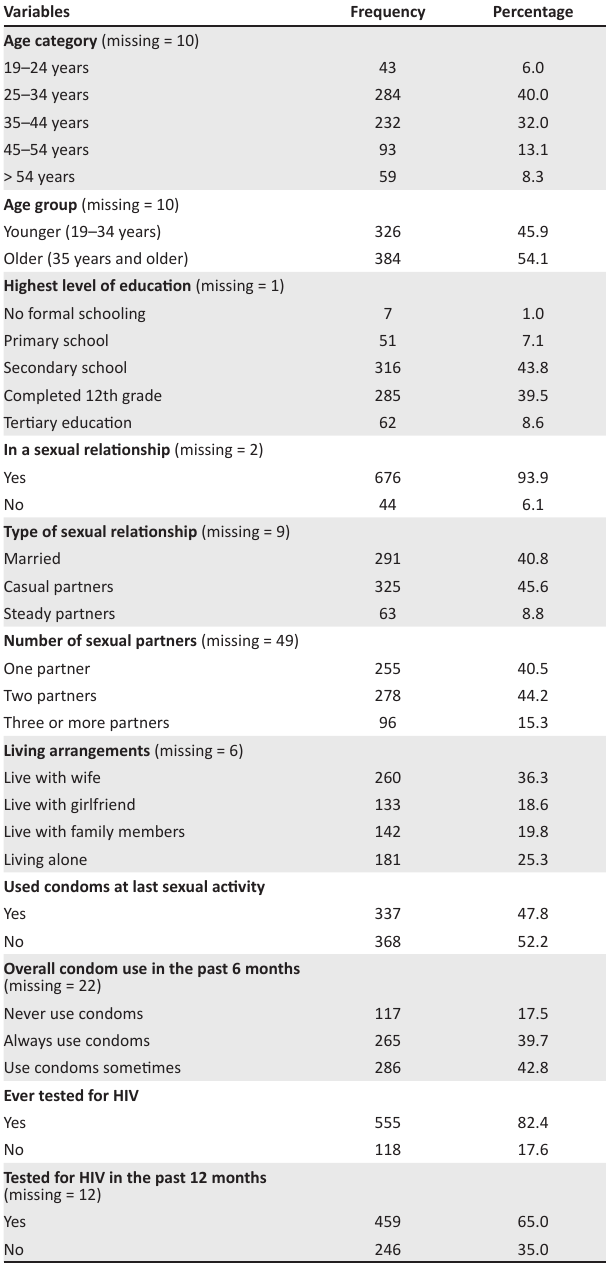
TABLE 1: Demographics and sexual behaviour characteristics of minibus taxi drivers in Gauteng Province ( n = 722).